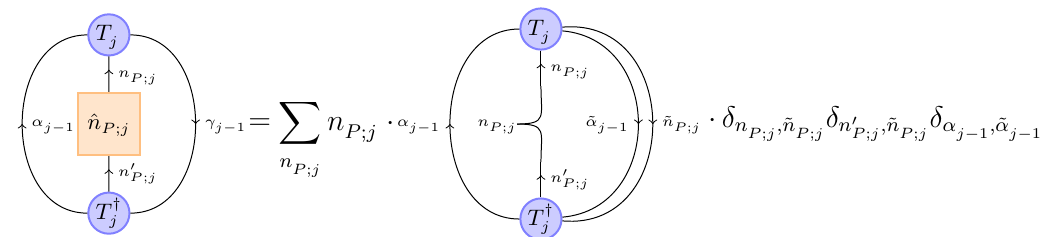
Figure 8: Expectation value of the local density 〈 ˆ n directly related to the diagonal elements of the 1RDM in the eigenbasis ˆ n